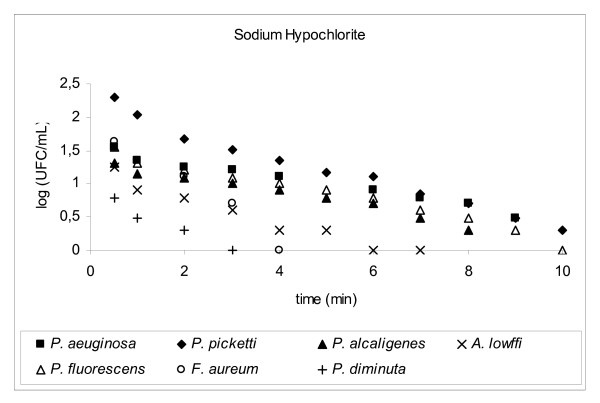
Graphic representation of the standard and in house microorganism reduction against different sanitizers.